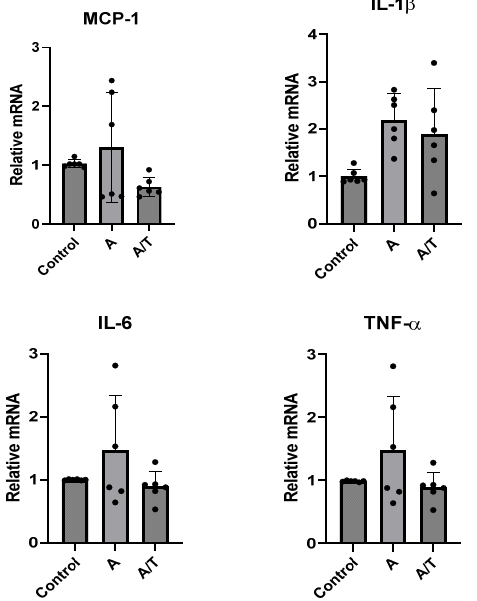
Figure 4. Gene expression of inflammatory cytokines (MCP-1, IL-1 β , IL-6, and TNF- α ) in human adipocytes in the presence of anastrozole alone (A) and in combination with testosterone (A/T). Control cultures were incubated in the presence of vehicle only. A complete set of six experiments for each treatment was performed from each subject and run in triplicate. Data are expressed as mean ± DS. Each black dot represents the mean of triplicate measurements of a single experiment.